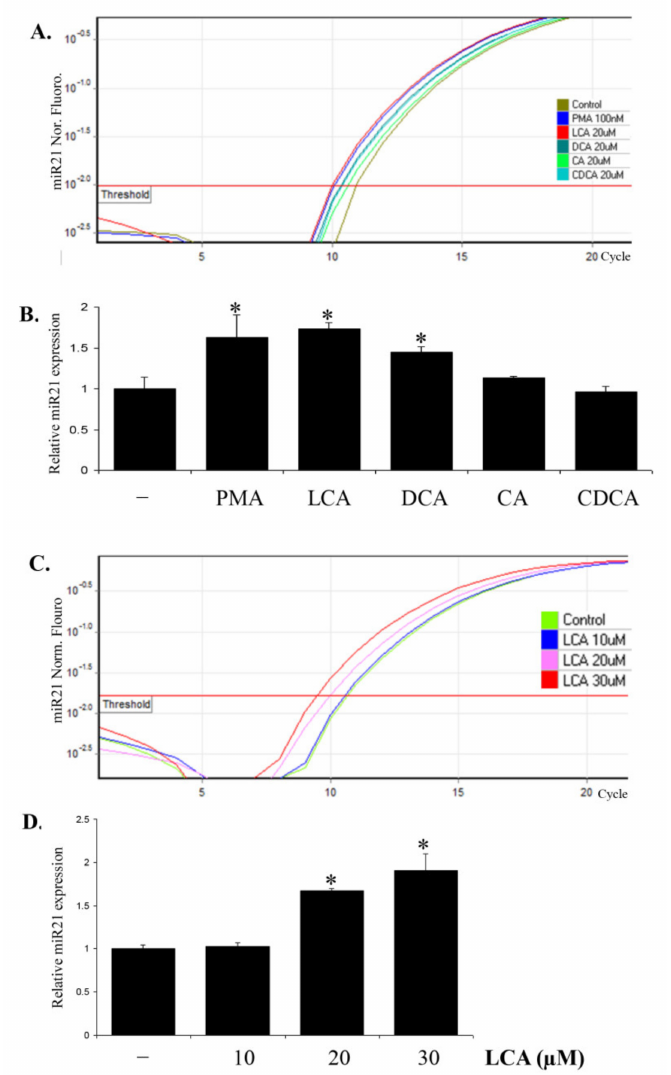
Figure 1. LCA induces miR21 expression in HCT116 cells. ( A , B ) HCT116 cells were incubated with indicated compounds including 100 nM PMA and 20 µ M of different BAs for 24 h. The cells were then extracted for total RNA for checking miR21 expression by Realtime-PCR. ( C , D ) HCT116 cells were incubated with LCA at different concentrations for 24 h and submitted to Realtime-PCR for miR21 expression. * p < 0.05 versus control. The above data represent the means ± SD from triplicate